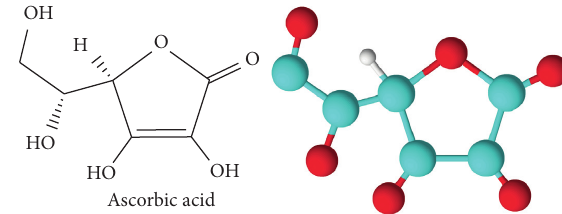
Figure 3: Chemical structure of ascorbic acid.